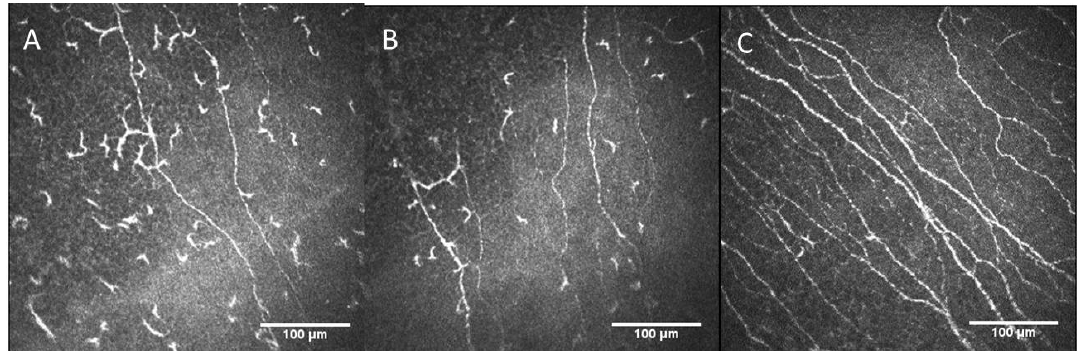
Figure 1. ( A ) Corneal nerve plexus in affected patient RE; ( B ) corneal nerve plexus in affected patient LE; ( C ) corneal nerve plexus image in a patient without systemic pathologies and no refractive surgery (control group). RE: right eye; LE: left eye. Dendritic cell density images in affected patient versus a control patient image are shown in Figure 2.